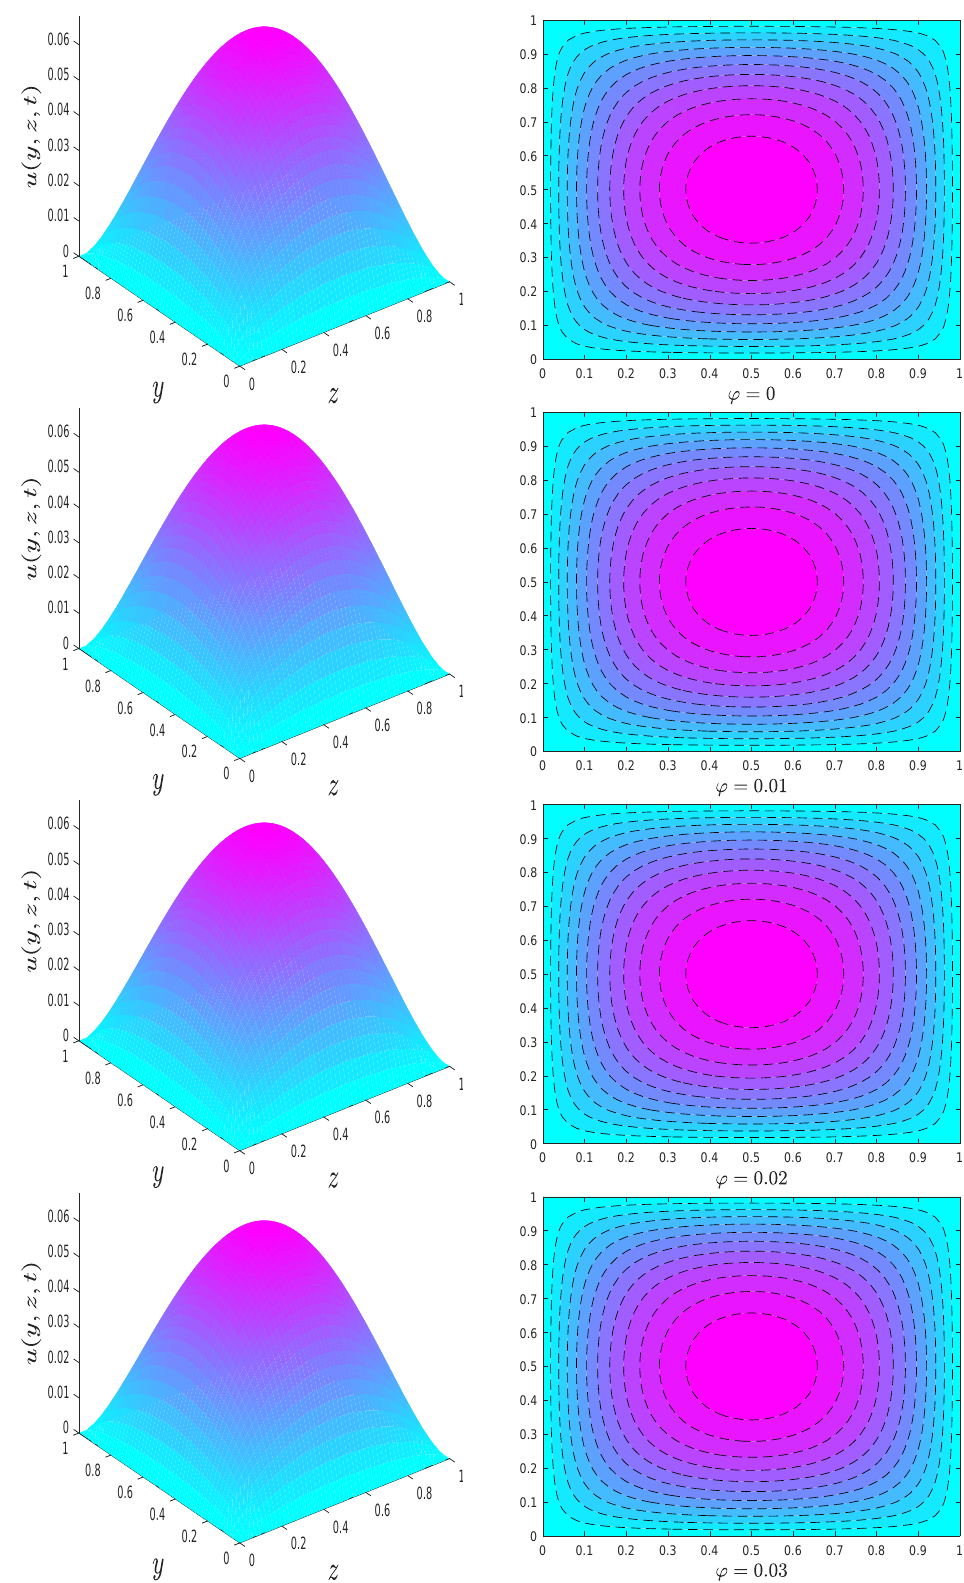
Figure 2. Velocity profile for different values of nanoparticle volume fraction ϕ